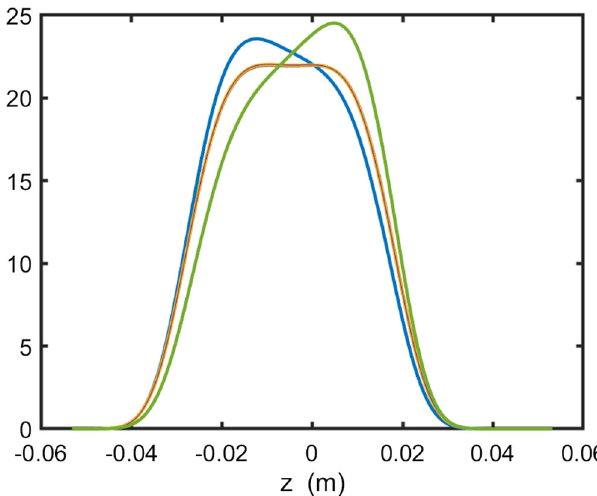
FIG. 10. A train of 26 with a guard bunch at its beginning (on the right) and at its end (on the left). The guard bunches have 3 times the charge of the inner bunches, to compensate for the charge missing in four gaps. The 24 inner bunches (in red) are nearly identical.